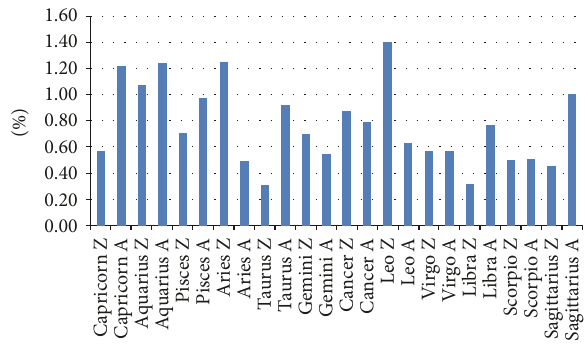
Figure 3: Percent frequency of complications with waxing (Z) and waning (A) moon per zodiac sign: least complications in Taurus (Z, waxing), most common in Leo (Z, waxing).